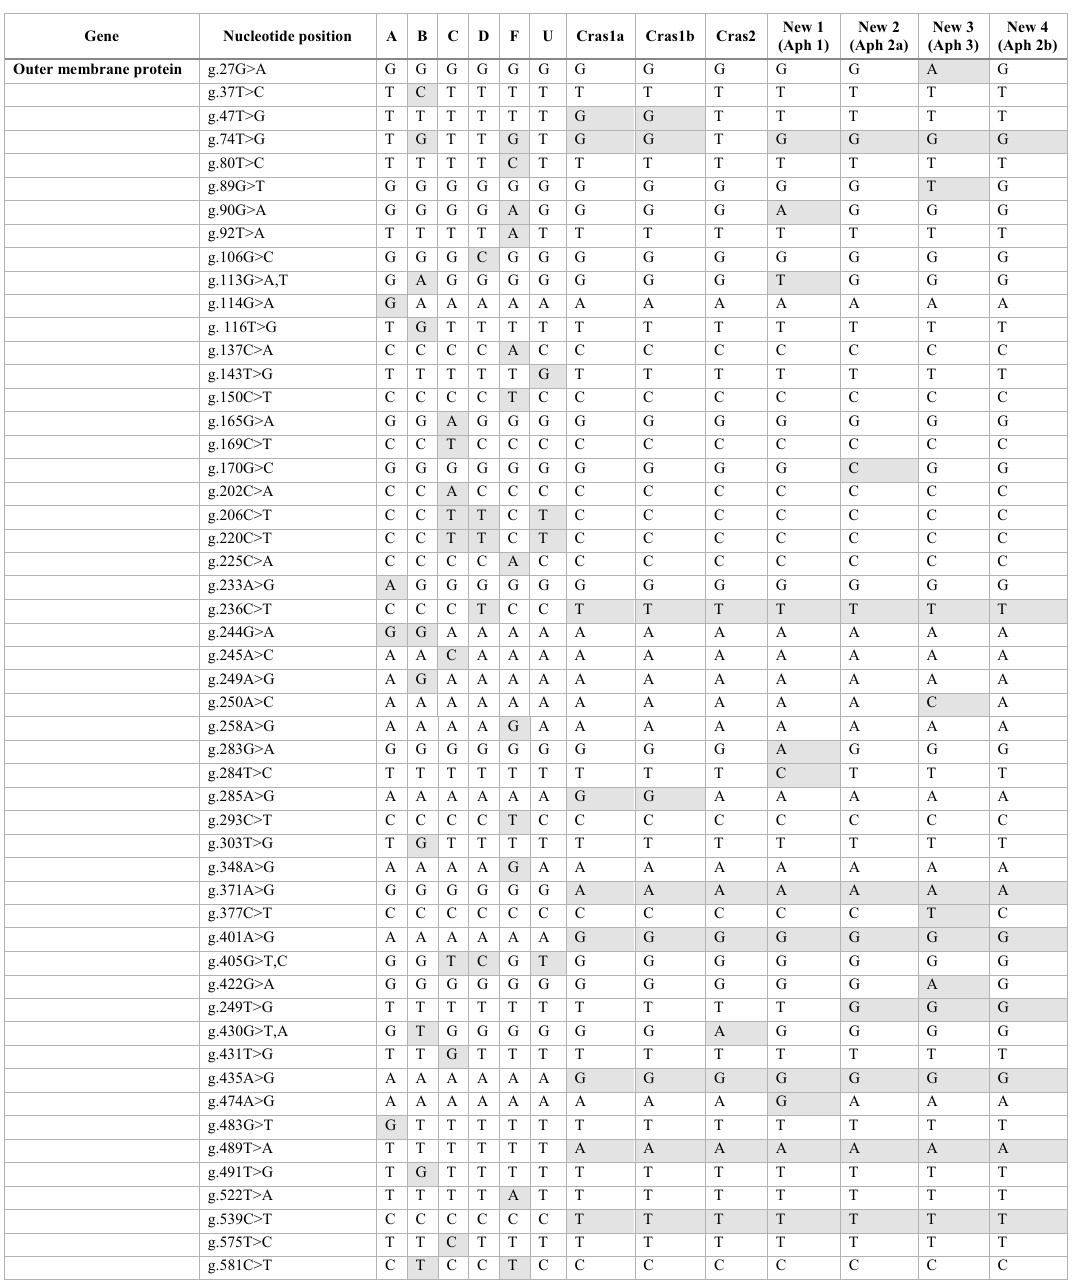
Table 3. Single nucleotide polymorphism comparison in the outer membrane protein gene between ‘ Ca. L. solanacearum’ haplotypes A, B, C, D, F, U, Cras1a, Cras1b, Cras2, and the four new sequence profiles, New1 (ON569104; haplotype Aph1), New2 (ON569105; haplotype Aph2a), New3 (ON569106; haplotype Aph3), and New4 (ON569107; haplotype